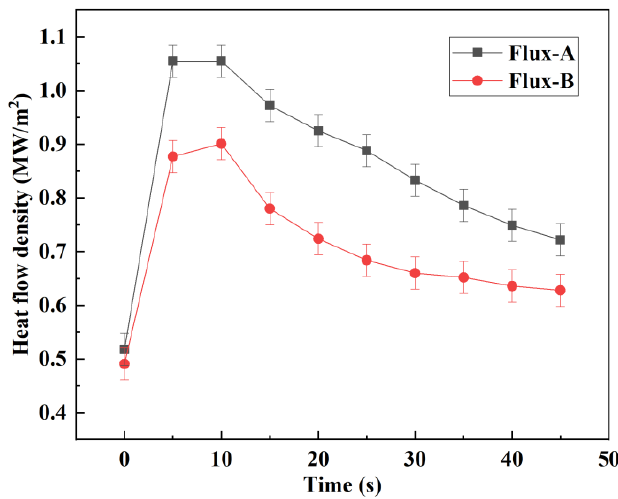
Figure 9. The heat flux density of mold flux films at different times.